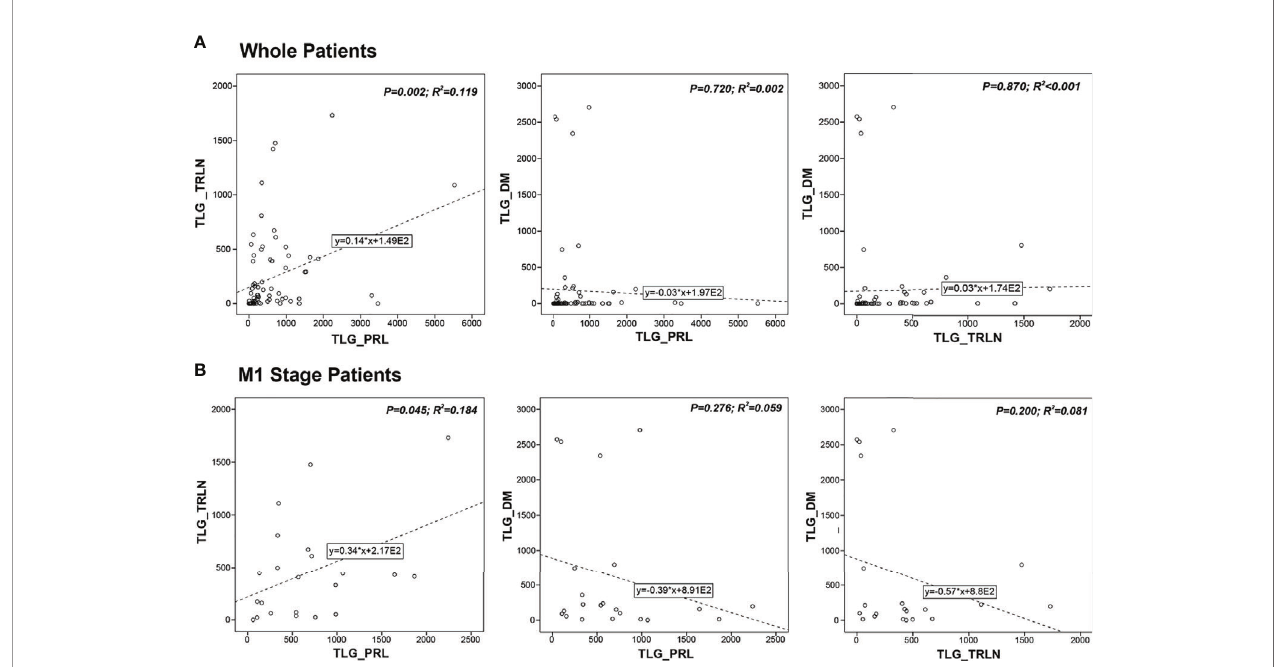
FIGURE 4 | Correlations between metabolic tumor burdens of primary lesion (PRL), thoracic lymph-node lesion (TRLN) and distant metastasis (DM) in (A) whole patients ’ group and (B) M1 stage patients ’ group. Linear correlation was found between TLG -TRLN and TLG -PRL , whereas TLG -DM did not show signi fi cant correlation with TLG -PRL and TLG -TRLN .